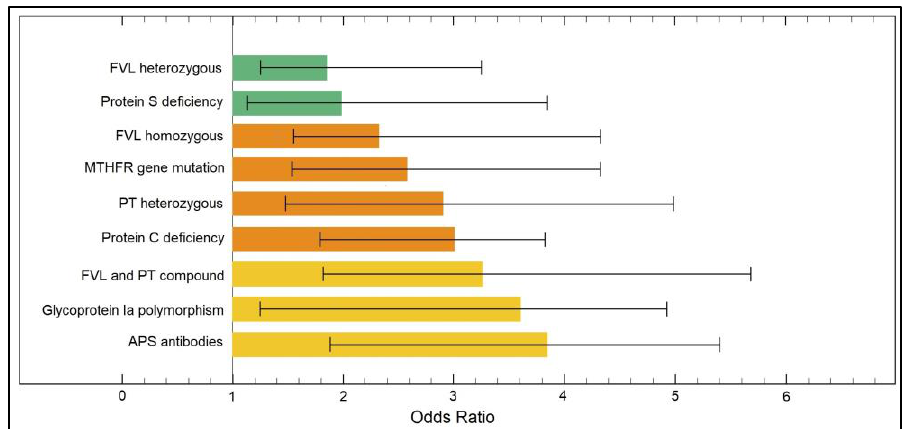
Figure 3. Risk factor analysis for late (second trimester) pregnancy loss.